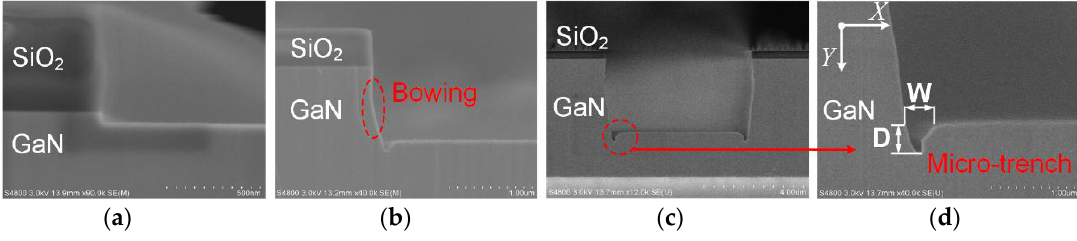
Figure 5. Cross SEM images of the sidewall of ( a ) photoresist (AZ5214E) and of ( b ) SiO 2 hard mask with PR on top and ( c ) without PR.